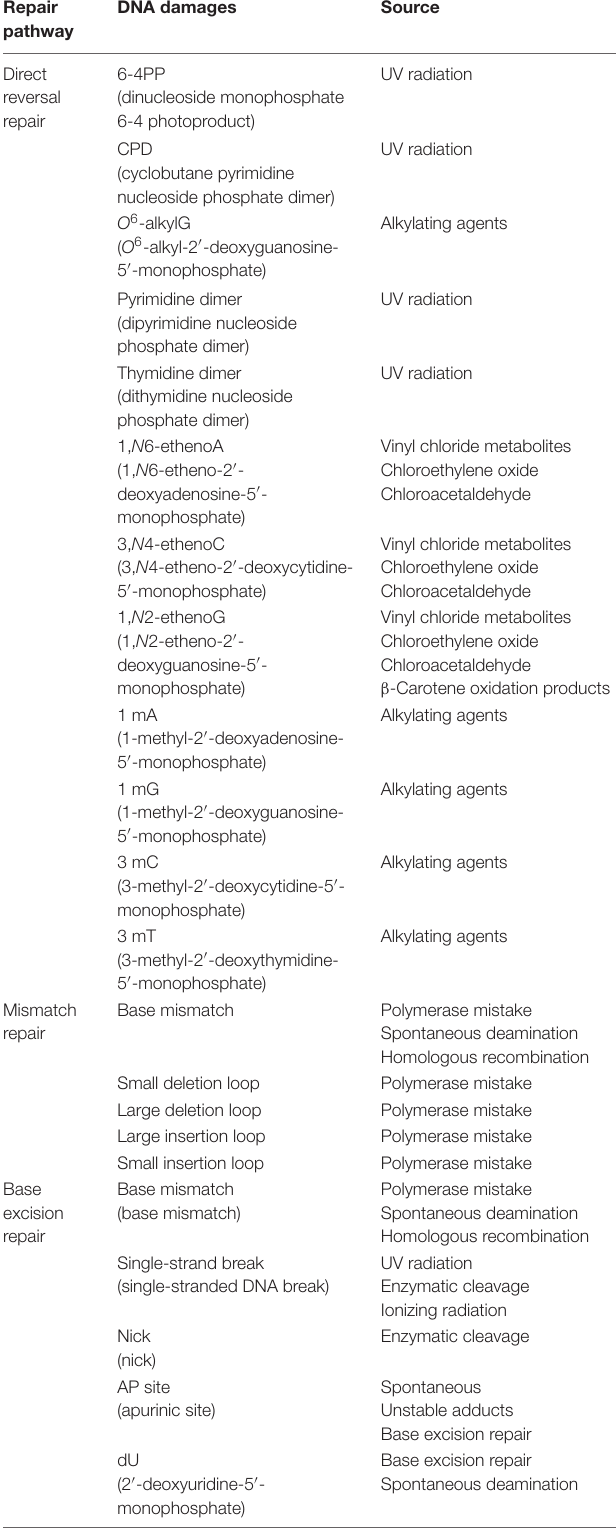
TABLE 1 | List of major DNA-damaging agents associated with different DNA repair pathways and their